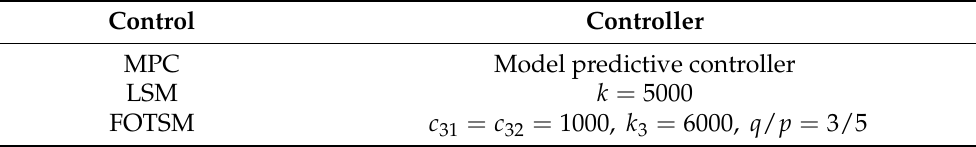
Table 3. Controller design parameters for the inverter